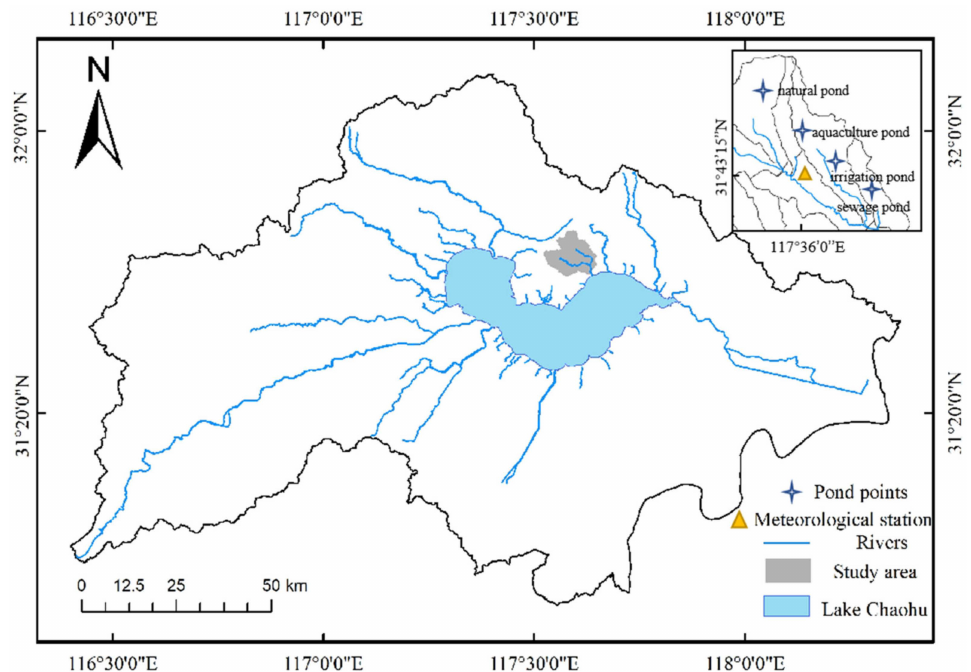
Figure 1. Map showing the geographical location of the Tongyang River watershed and sampling ponds. The blue area indicates Lake Chaohu; The blue lines indicate inflow and outflow rivers; The gray area indicates the study area; The blue diamonds denote different sampling ponds, and the yellow triangle denotes a local automatic meteorological observation station in the